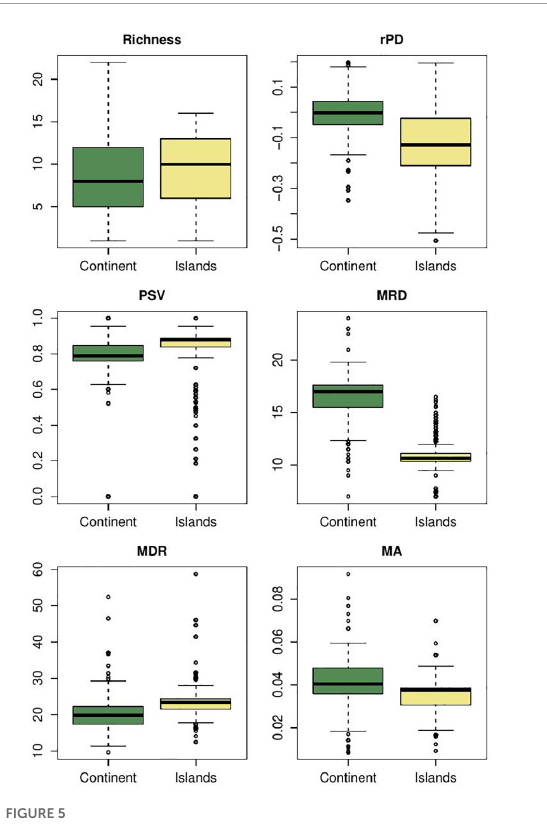
FIGURE4 Variation of phylogenetic metric values in hylid frogs for the tropics and extra-tropical regions. rPD: residual phylogenetic diversity (i.e., after controlling for species richness); PSV, phylogenetic species variability; MRD, mean root distance; mDR, mean diversification rate; mAges, average ages of species. Y-labels correspond to the values of each metric. Comparisons of metrics between regions were evaluated using Bayesian ANOVAs and all were significant (Maximum A posteriori p -values < 0.001).